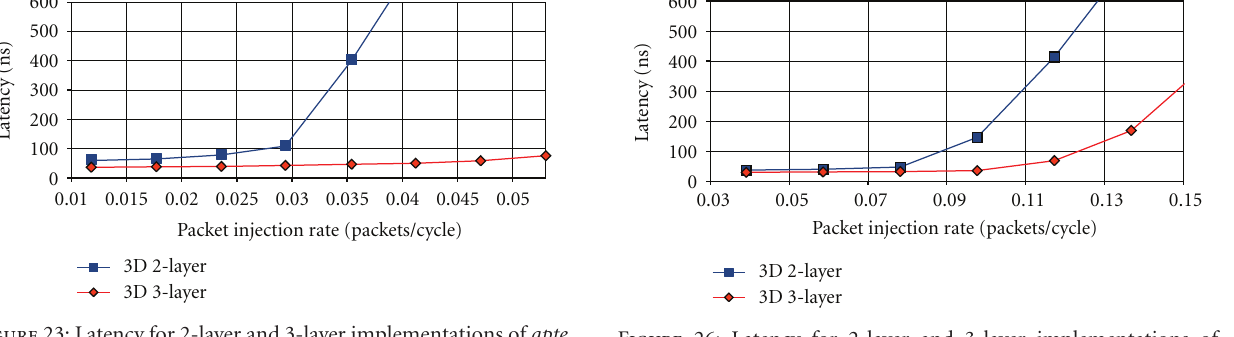
Figure 23: Latency for 2-layer and 3-layer implementations of apte .